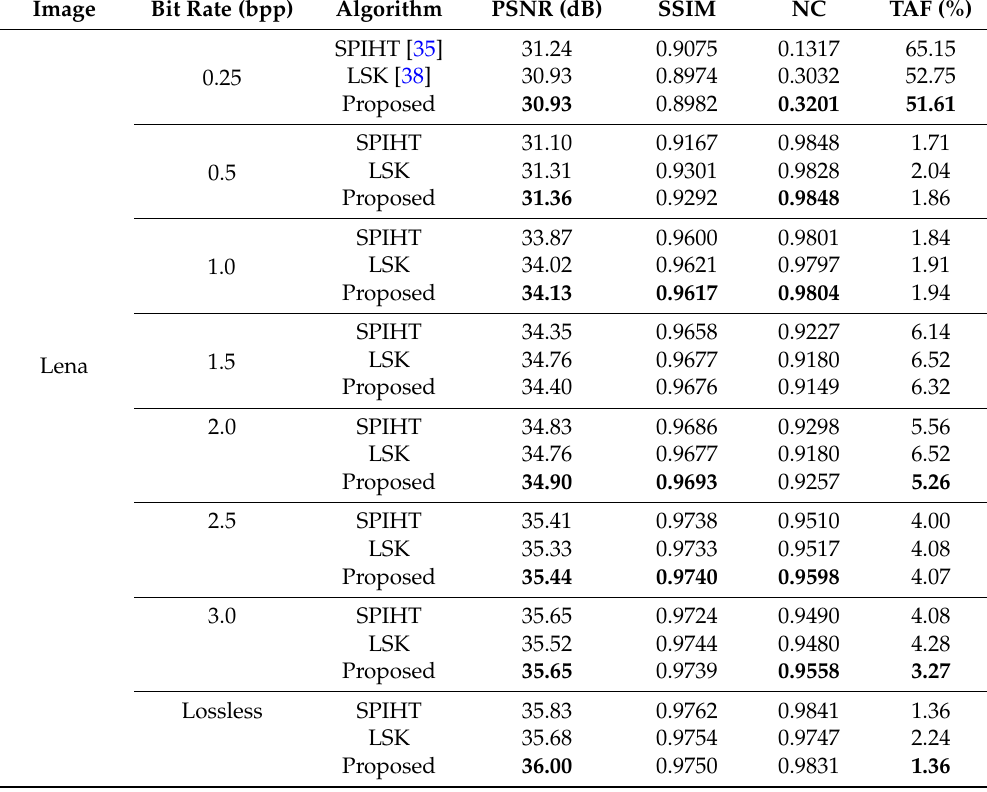
Table 1. PSNR (Peak signal to noise ratio), structural similarity (SSIM), tamper assessment function (TAF), and Normalized Correlation (NC) performance on the Lena Image’; SPIHT: set partitioning in hierarchical trees; LSK: Listless SPECK. Bolded numbers indicate improvement in results.